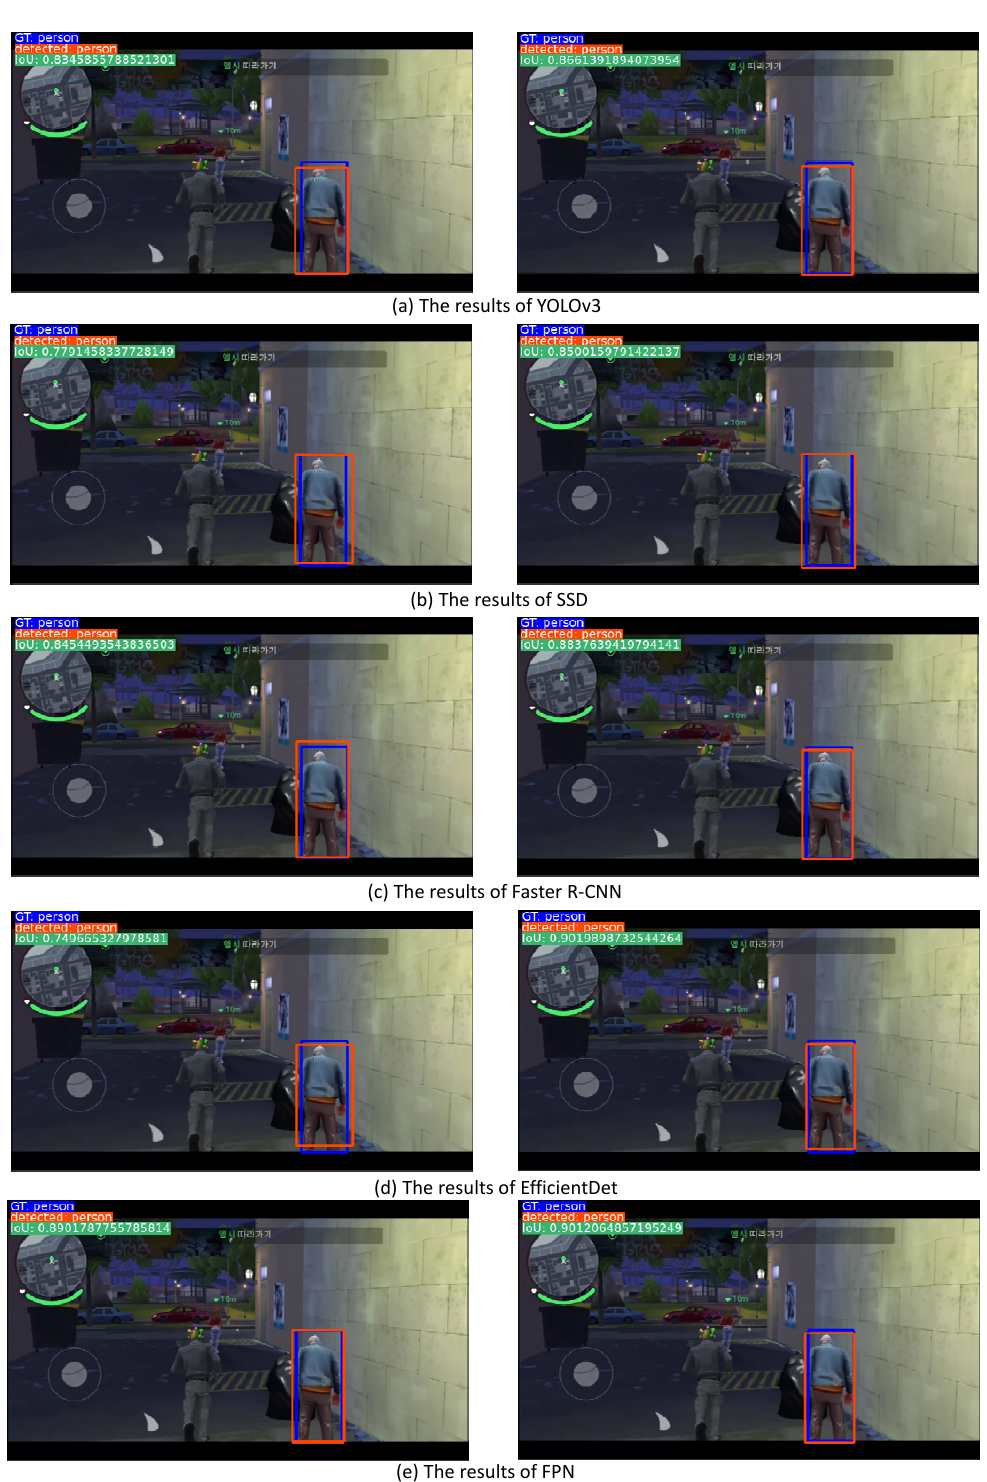
Figure A8. Comparison of the bounding box detection on game Gangstar, New Orleans . The left column is the result from the models trained by PASCAL VOC and the right column is the result from the models trained by PASCAL VOC and game